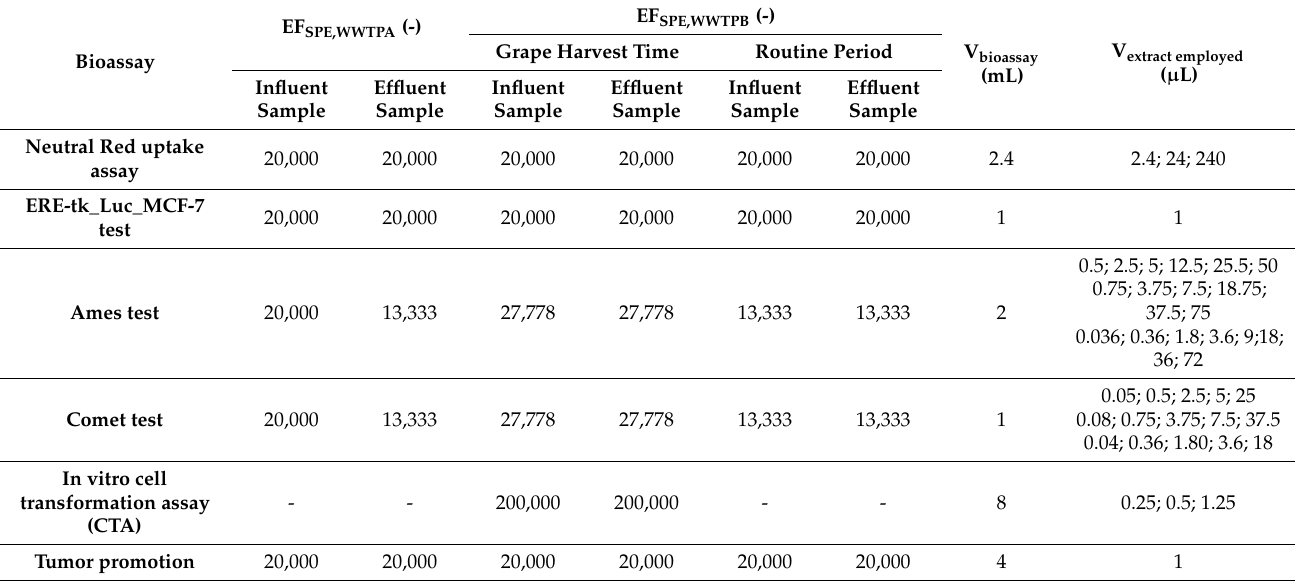
Table 2. Enrichment factors (EF) and volumes for the calculation of the dilution factors